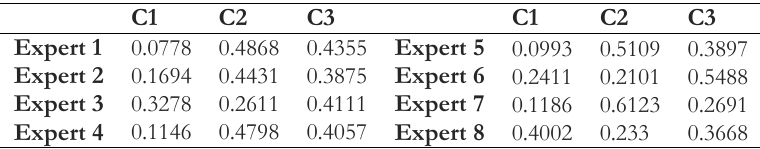
Table 1. Weight of criteria from the perspective of